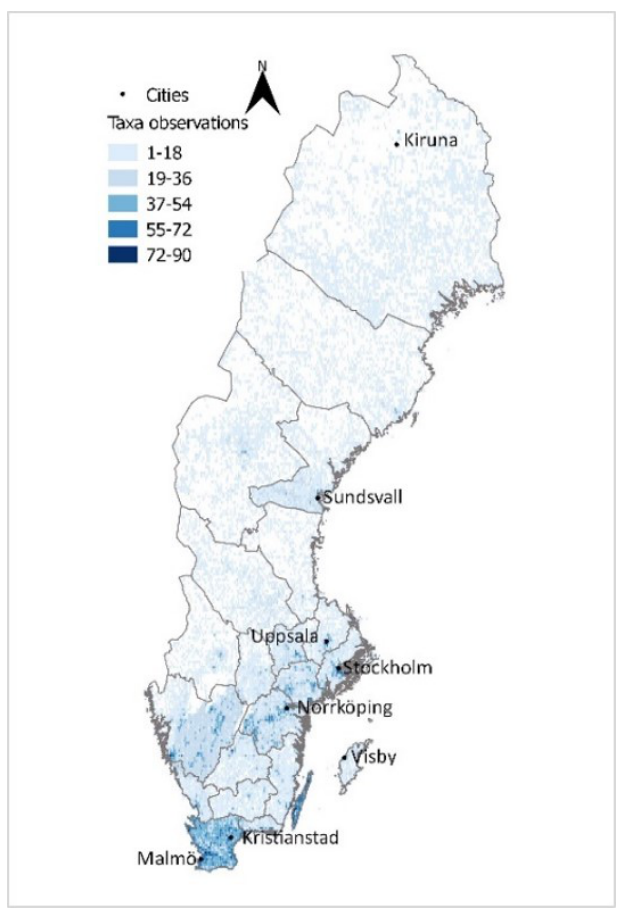
Figure 2. The number of occurrences of the priority taxa across